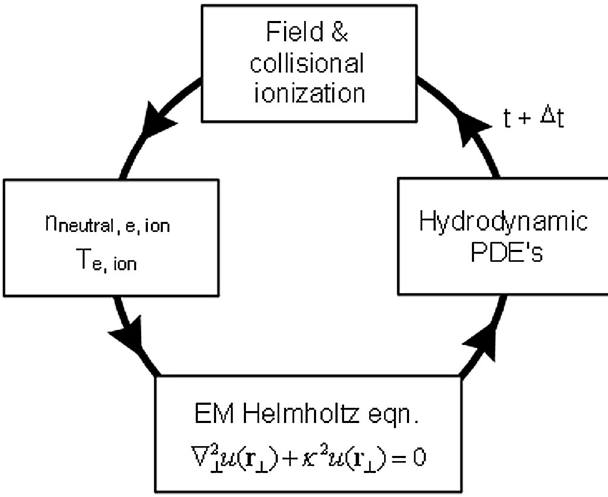
FIG. 4. Flow diagram for Bessel-beam model computations.